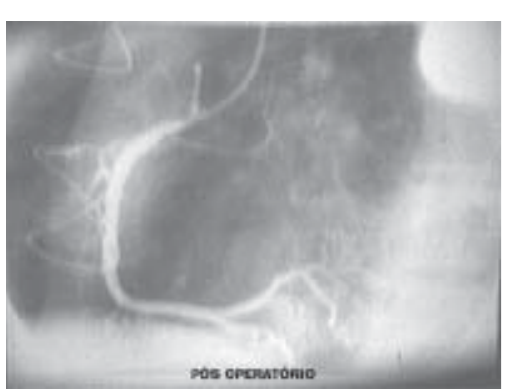
Fig. 2A - Post-operative angiography demonstrating the right coronary artery without fistulae.